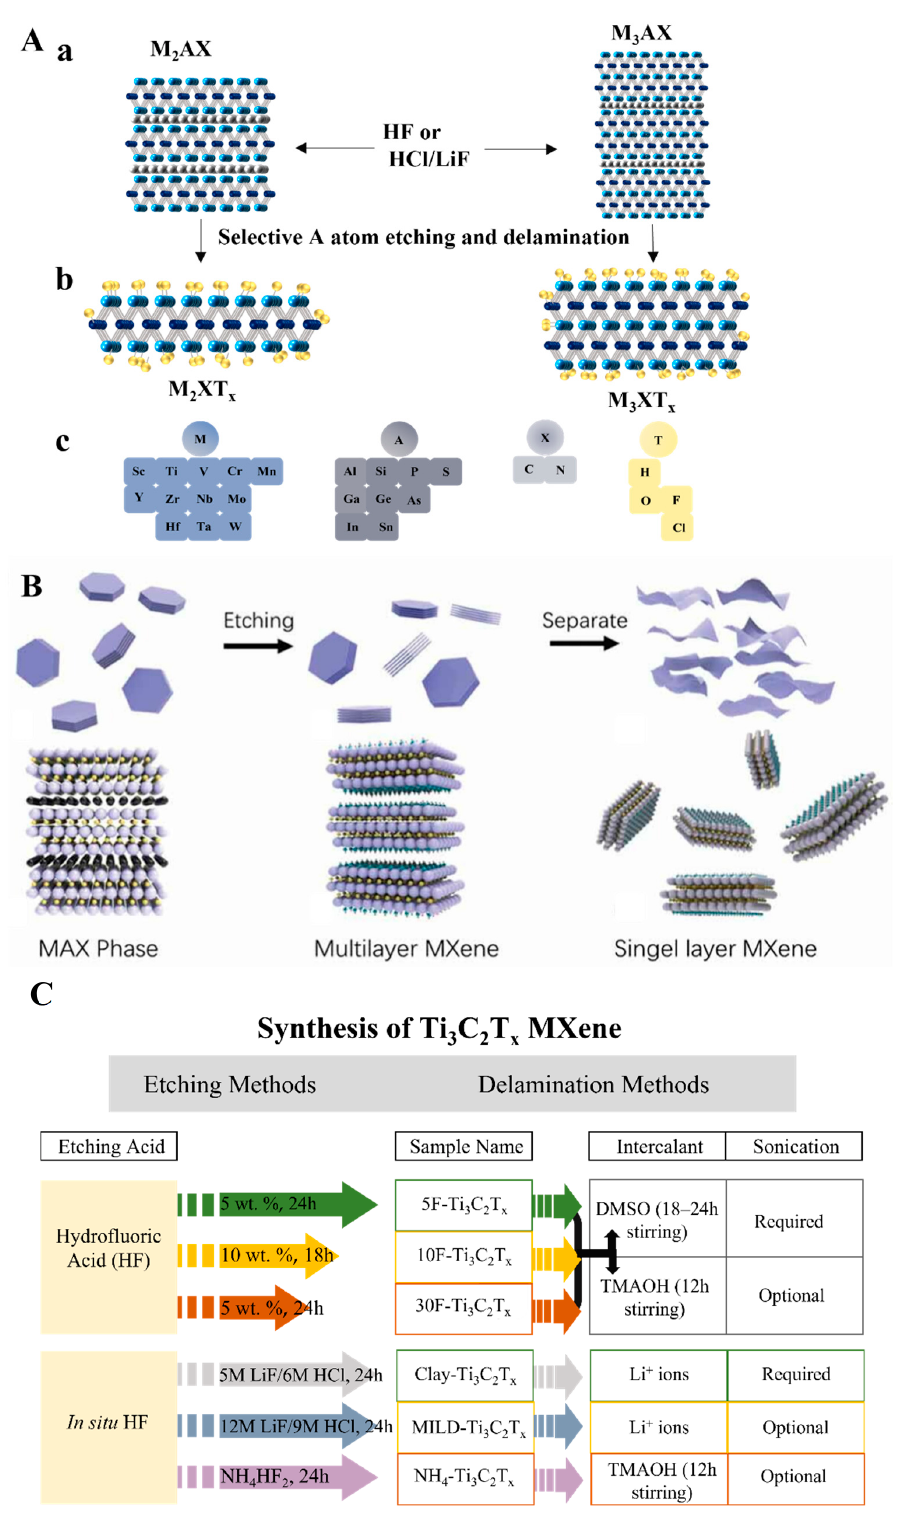
Figure 1. ( A ) MAX phase and its etched products. ( a ) Three typical MAX phase structures with selective etching sites (atoms in red). ( b ) Selectively etched products (MXene) with surface modification (atoms in yellow). ( c ) Atoms in MAX phases and MXene structures. Redrawn based on Ref. [11]. ( B ) Illustration for MXene top-down synthesized process from its precursor. Reproduced from Ref. [18]. ( C ) General idea for MXene top-down etched from MAX phases with two typical routes. Redrawn with permission from Ref.